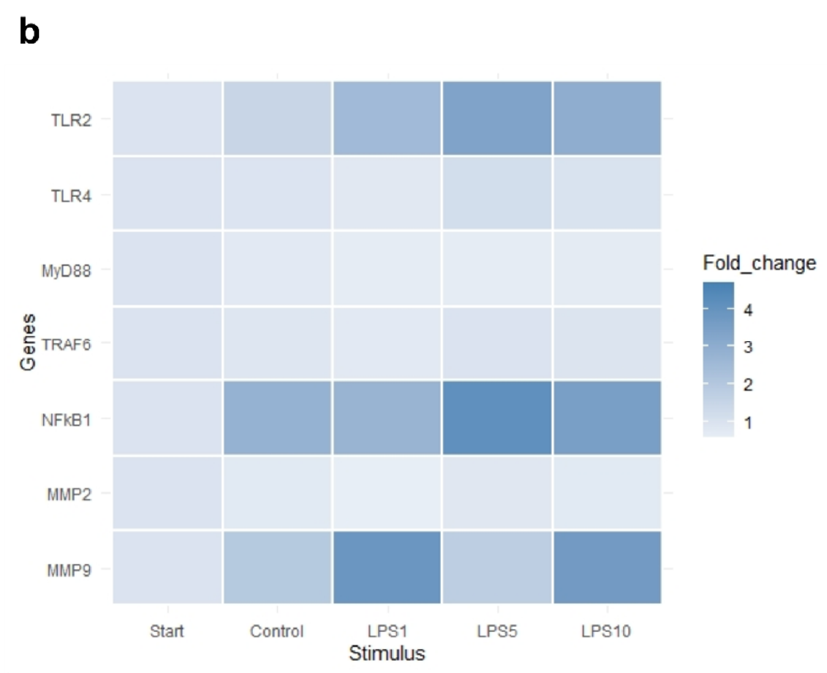
Figure 7. Heat map of the expression of ( a ) highly affected and ( b ) less affected genes of control explants before incubation (Start), untreated explants (Control) after 4 h of incubation, and explants incubated with 1, 5, and 10 µ g/mL LPS (LPS1, LPS5, LPS10) for 4 h. n = 5 animals. There was no effect of any treatment on expression of TLR4, MyD88, and TRAF6 ( p > 0.05; Table 3). Expression of TLR2 was upregulated after 4 h of incubation when explants were incubated with 1, 5, or 10 µ g/mL LPS ( p < 0.05; Table 3). NFKB1, IL1B, and CXCL8 expression was upregulated in control explants ( p < 0.05) and explants incubated with 1, 5, or 10 µ g/mL LPS ( p < 0.05) after 4 h of incubation compared to control explants at 0 h (Table 3). TNF- α expression was upregulated in control explants ( p < 0.05) and explants incubated with 5 or 10 µ g/mL LPS ( p < 0.05) after 4 h of incubation compared to control explants at 0 h (Table 3). There was no difference in the expression of genes comparing control explants after 4 h of incubation to explants incubated for 4 h with 1, 5, or 10 µ g/mL ( p > 0.05). Table 3. Expression of measured genes of control explants before incubation, control explants after 4 h of incubation, and explants incubated for 4 h with 1, 5, and 10 µ g/mL LPS. Values are fold changes expressed relative to the control explants before incubation (Control, 0 h). n = 5 animals.